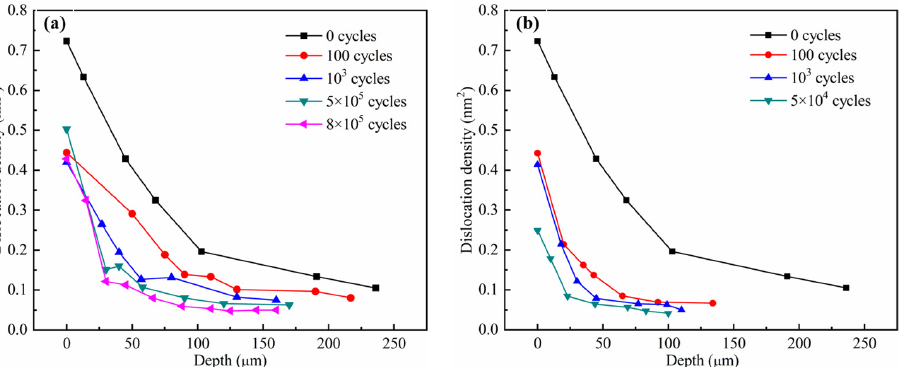
Figure 13. Distributions of dislocation density as a function of depth from the top surface under different cycle numbers: ( a ) 10 MPa; ( b ) 320 MPa.